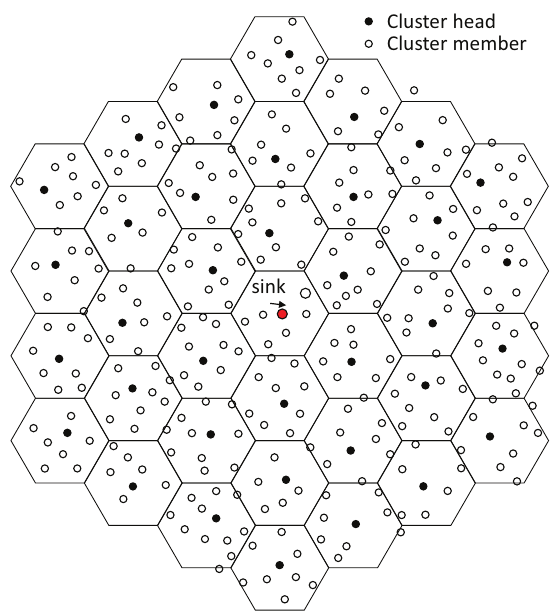
Figure 1. Wireless Sensor Network Scenario with r max =